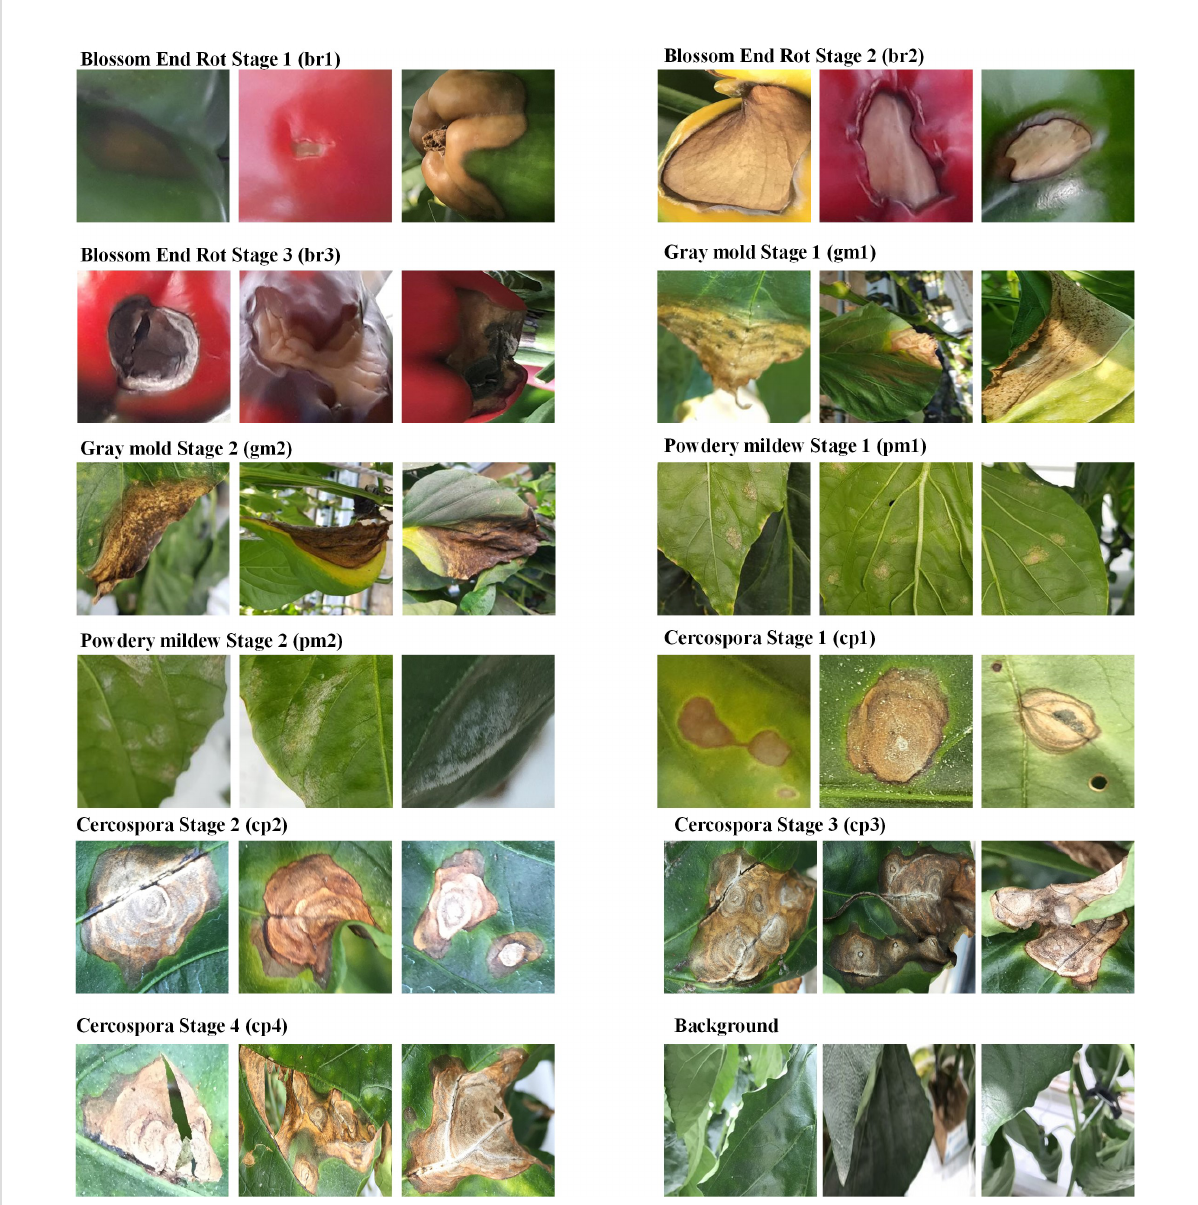
FIGURE 3 Image showing visual differences of various severity stages belonging to the diseases present in the paprika